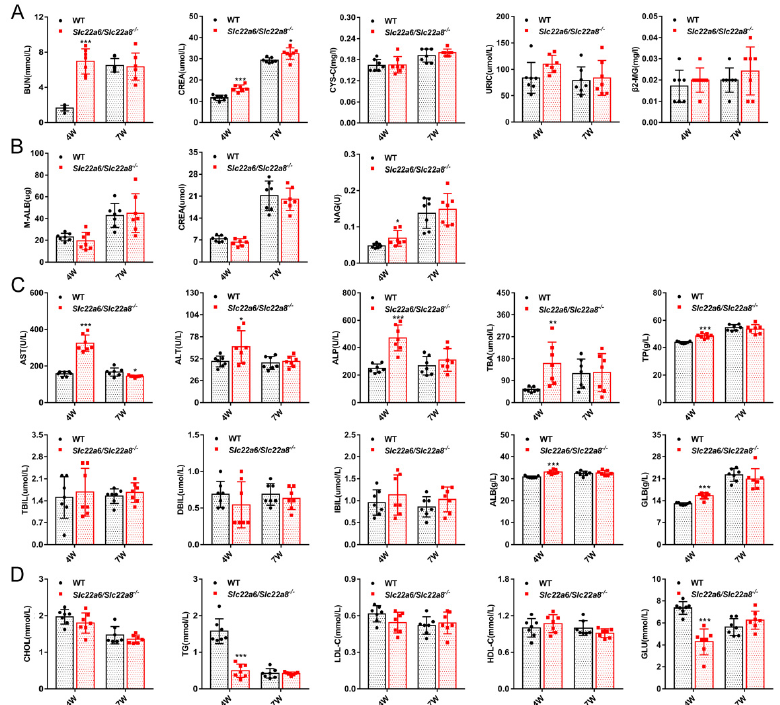
Figure 2. Effects of Slc22a6/Slc22a8 double-knockout on the biochemical indicators in 4W and 7W WT and KO rats. Biochemical indicators include renal function, liver function, blood lipids and glucose indexes. ( A ) Serum renal function indicators BUN, CREA, CYS-C, URIC and β 2-MG. ( B ) Urine early kidney injury markers M-ALB, CREA and NAG. ( C ) Serum liver function indicators AST, ALT, ALP, TBA, TP, TBIL, DBIL, IBIL, ALB and GLB. ( D ) Serum lipids CHOL, TG, LDL-C, HDL-C and glucose indicators. Data are presented as mean ± SD (n = 7). *, p < 0.05; **, p < 0.01; ***, p < 0.001 compared with WT rats.